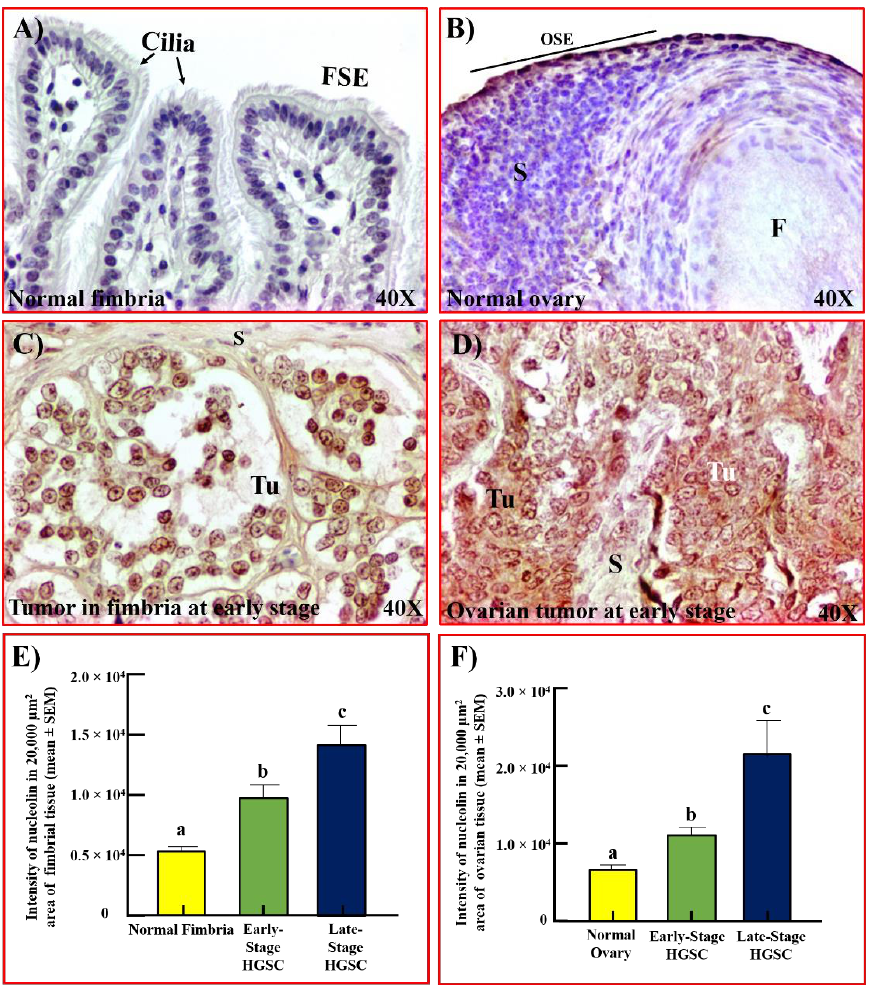
Figure 5. Nucleolin expression in normal and ovarian HGSC in hens. ( A , B ) Sections of normal oviductal fimbria ( A ) and ovary ( B ) in healthy hens showing very weak to moderate staining for nucleolin by the FSE and OSE cells, respectively. ( C ) Section of an oviductal fimbrial tumor showing strong expression for nucleolin. ( D ) Section of ovarian HGSC at an early stage in a hen showing staining for nucleolin. ( E ) The intensity of immunohistochemical staining of nucleolin was quanti- fied and summarized as the mean ± SEM in a 20,000µm 2 area of tissue. Each bar represents the intensity of nucleolin expression in hens with normal fimbria ( n = 5) or fimbria with tumors at early ( n = 6) and late stages ( n = 4) of HGSC. Compared with normal fimbria, the intensity of nucleolin expression was significantly higher in fimbria with tumors at early-stage HGSC ( P < 0.05) and in fimbria with tumors at late stages ( P < 0.01). Bars with different letters are significantly different in their nucleolin expression. ( F ) The intensity of immunohistochemical expression of nucleolin in nor- mal ovaries ( n = 5) or ovarian HGSC at early ( n = 5) and late stages ( n = 5) summarized as the mean ± SEM in a 20,000µm 2 area of tissue. Each bar represents the intensity of nucleolin expression in hens with normal ovaries or with ovarian HGSC at early and late stages. Compared with normal ovaries, the intensity of nucleolin expression was significantly higher in hens with ovarian HGSC at an early stage ( P < 0.05) and increased further in hens with ovarian HGSC at late stages ( P < 0.01). Bars with different letters are significantly different in their intensity of nucleolin expression. F = follicle, FSE/OSE = fimbrial/ovarian surface epithelium, S = stroma, Tu = tumor. Magnification = 40X.